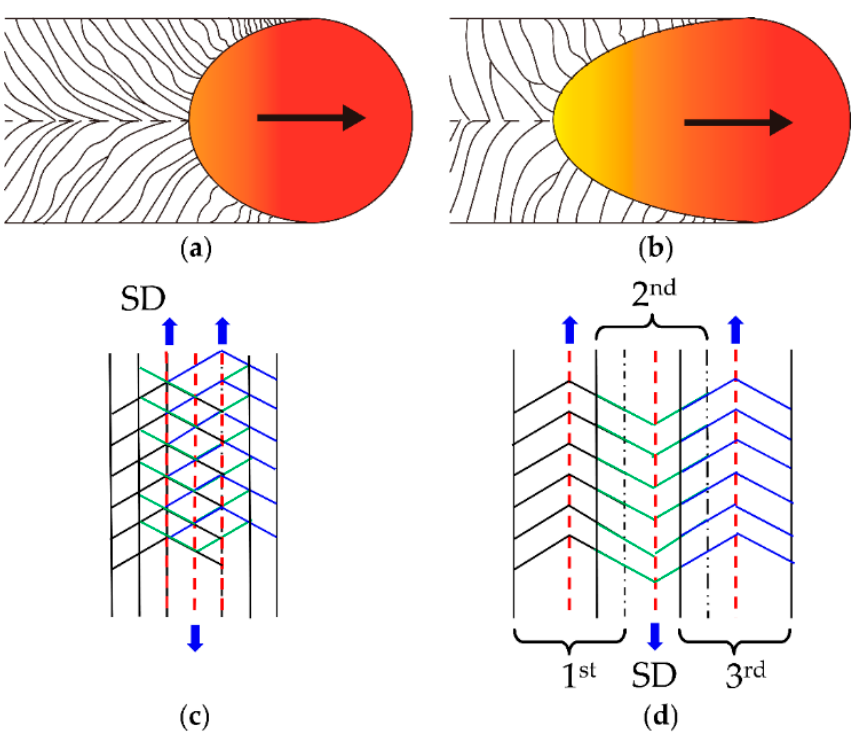
Figure 11. Illustration of grain growth and molten pool morphology under different scanning speeds and hatch spacing. ( a ) low scanning speed, ( b ) high scanning speed, ( c ) low hatch spacing, ( d ) high hatch spacing.